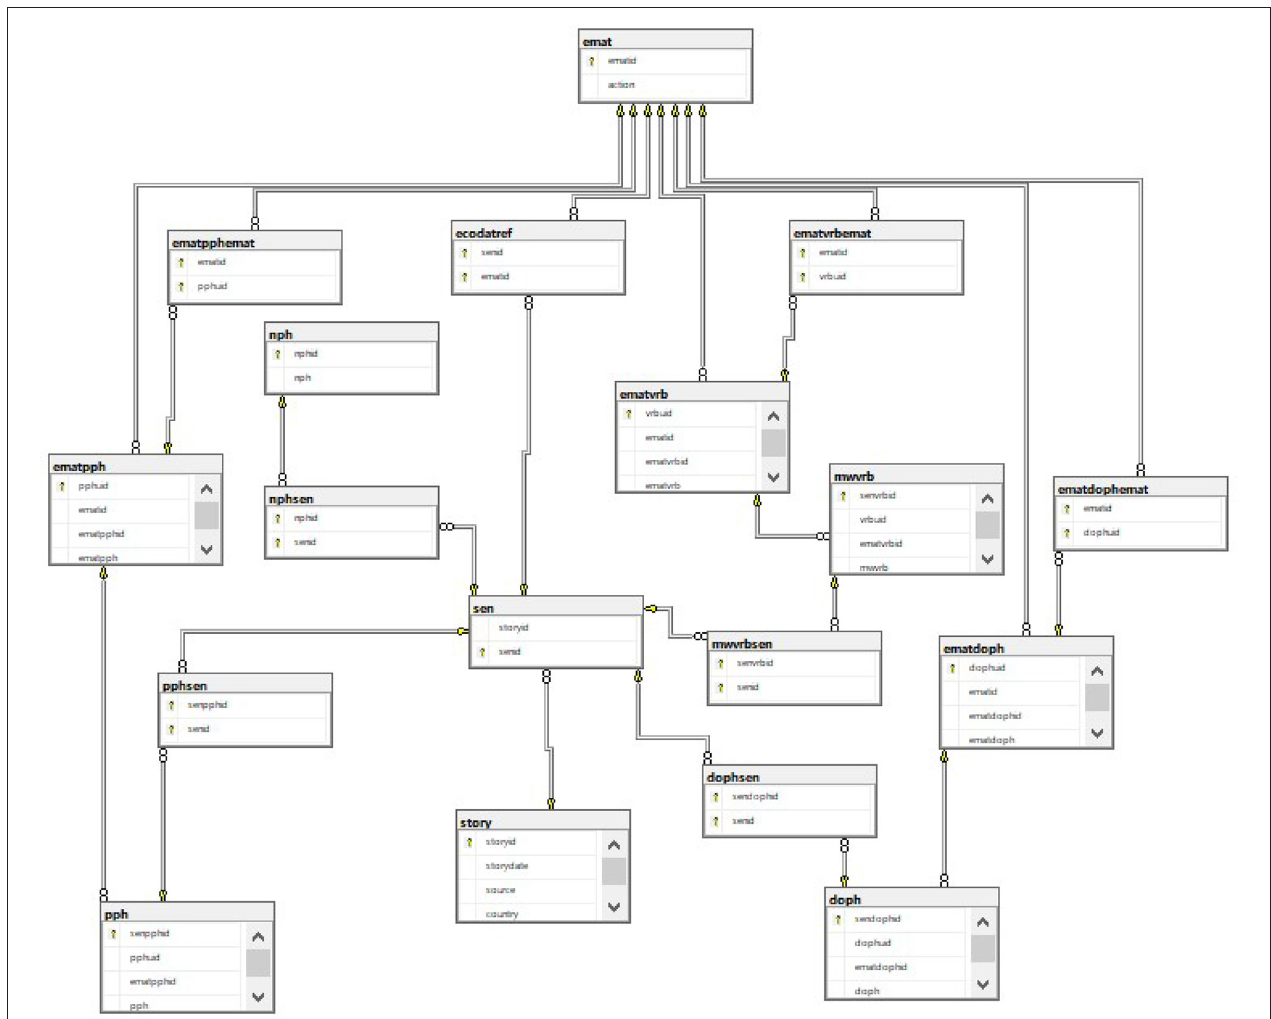
FIGURE 1 | Entity relationship diagram of the EMT database drawn using the Database Diagram TM tool in SSMS. Rectangles are entities. Rows within rectangles are attributes that take on values. An arrow into an entity indicates a source entity can map to only one entity whereas a line indicates a source entity can map to many